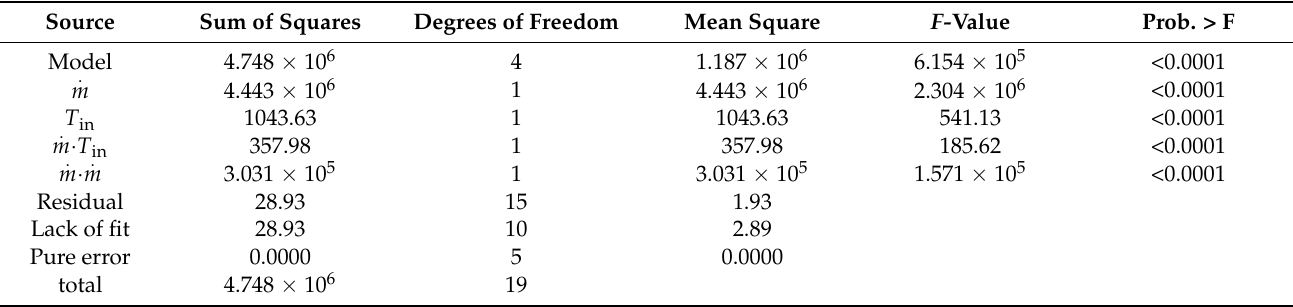
Table A3. The ANOVA for the pressure drop (after backward